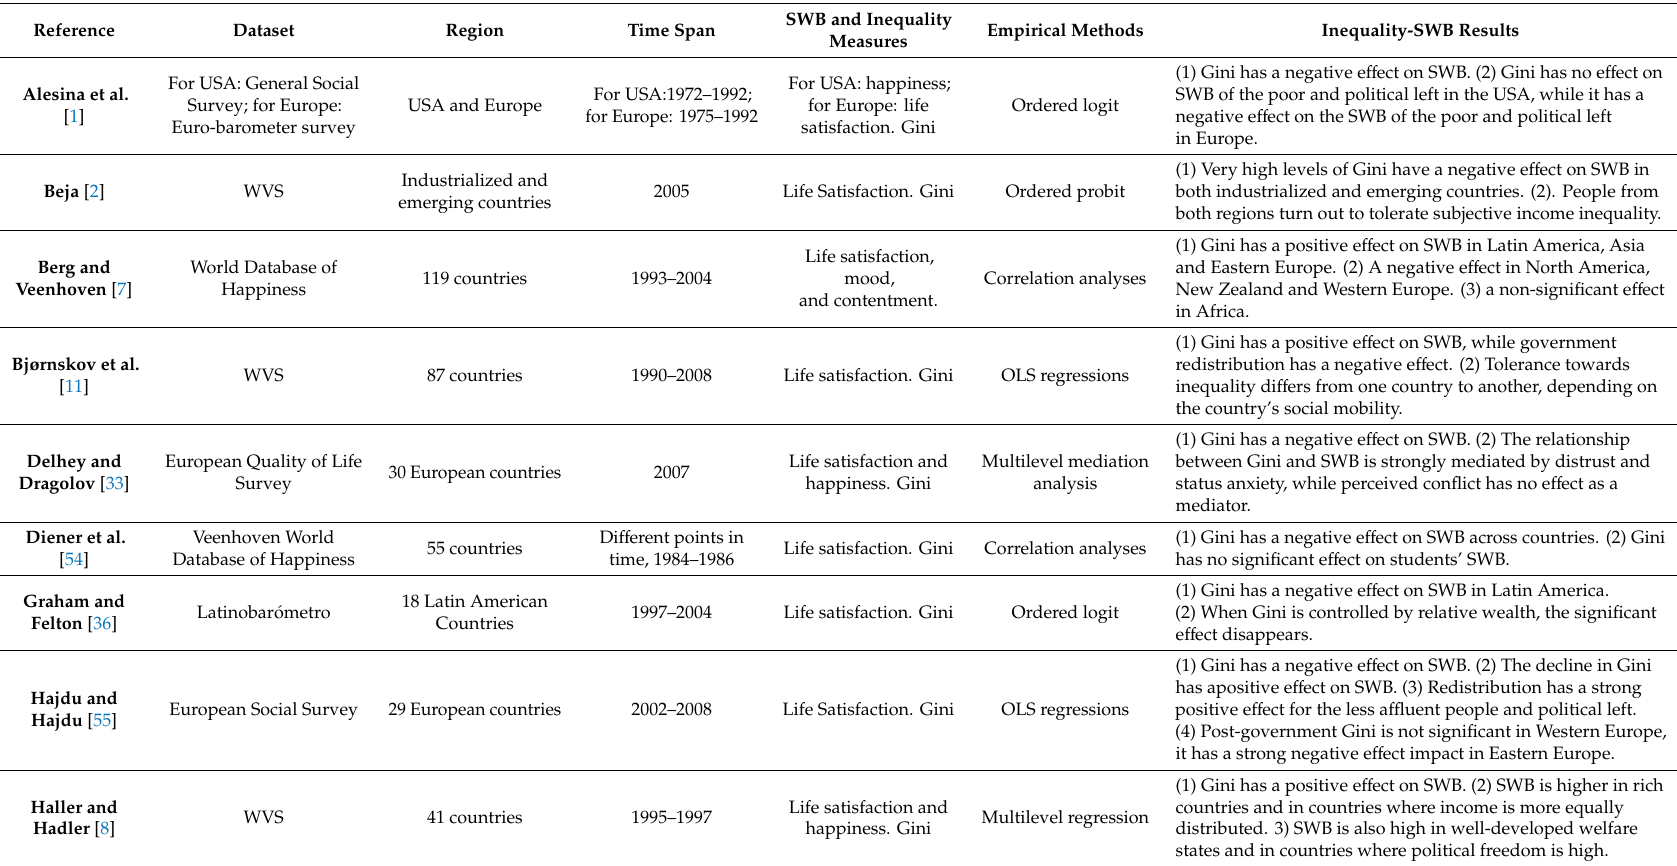
Table A5. Articles on inequality and subjective well-being (SWB), summary of the